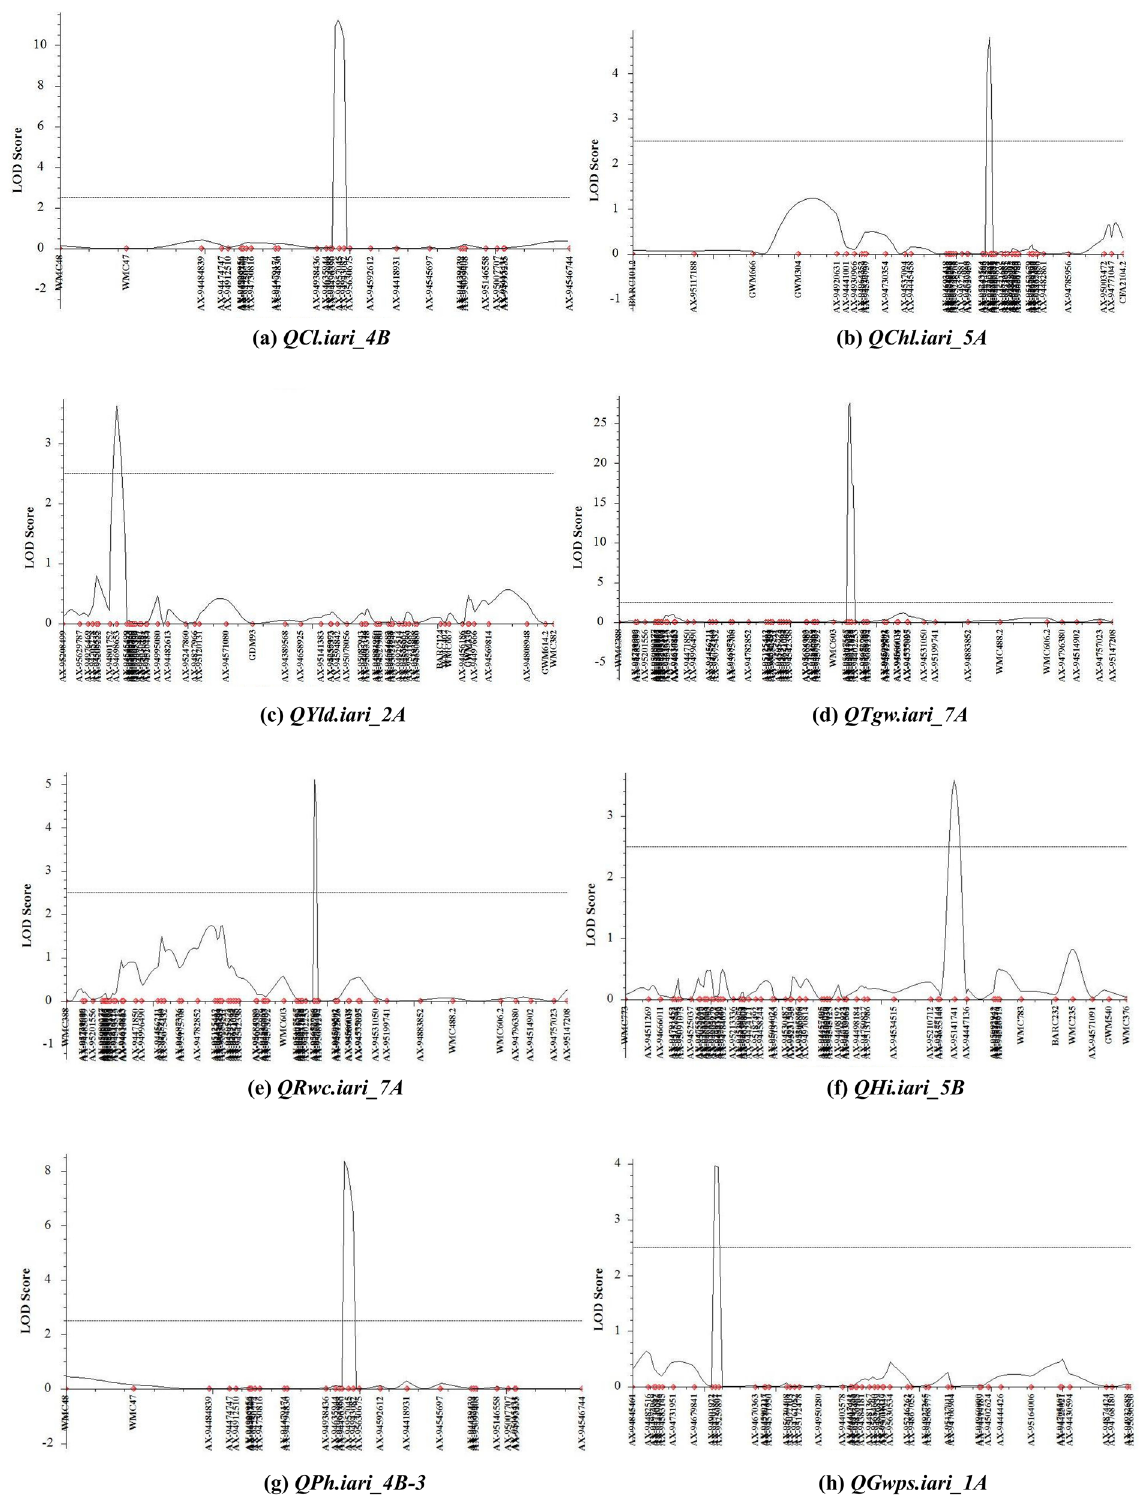
Figure 3. LOD threshold graphs of ( a ) coleoptile length ( b ) chlorophyll content ( c ) grain yield ( d ) thousand grain weight ( e ) relative water content ( f ) harvest index ( g ) plant height ( h ) grain weight per